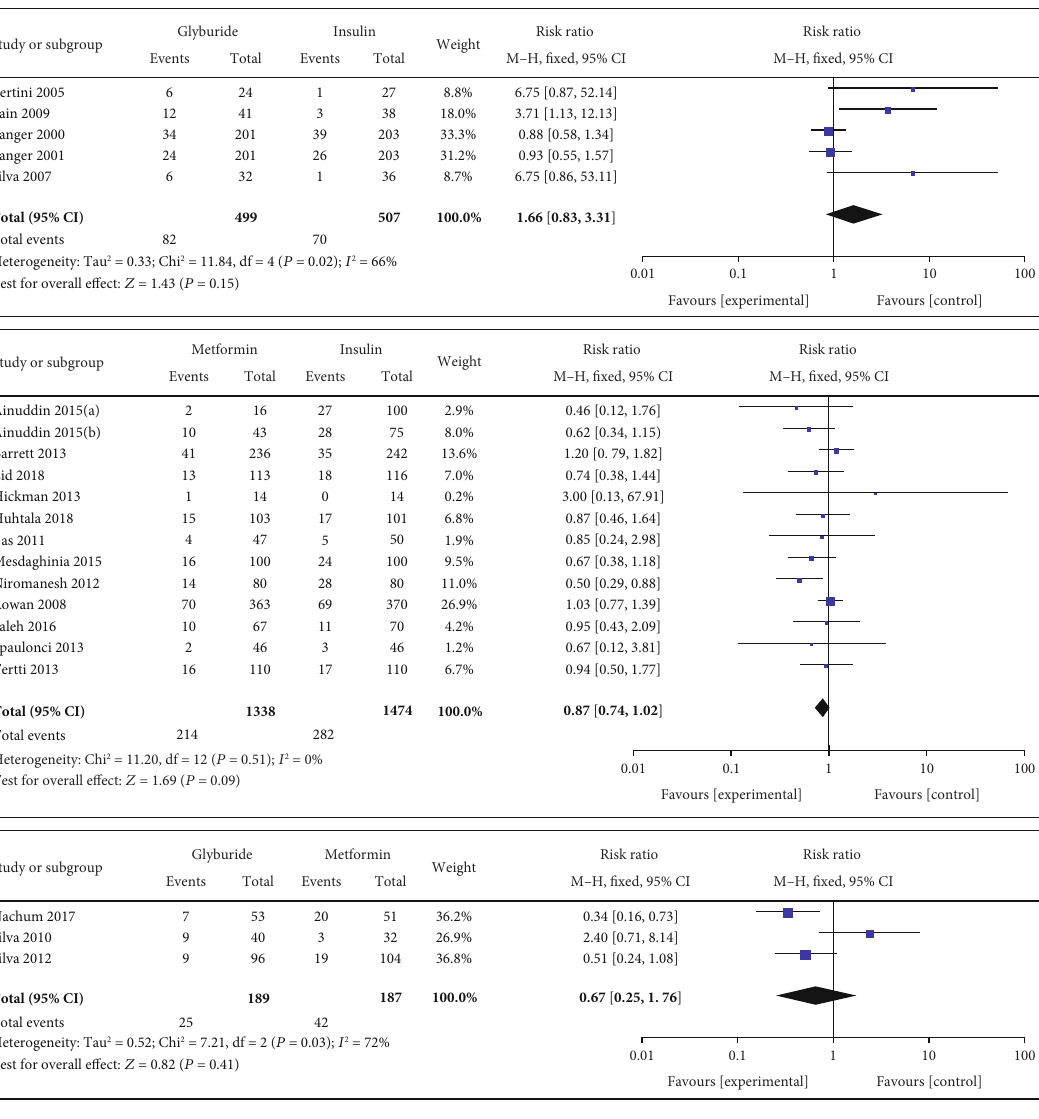
Figure 13: Large for gestational age.